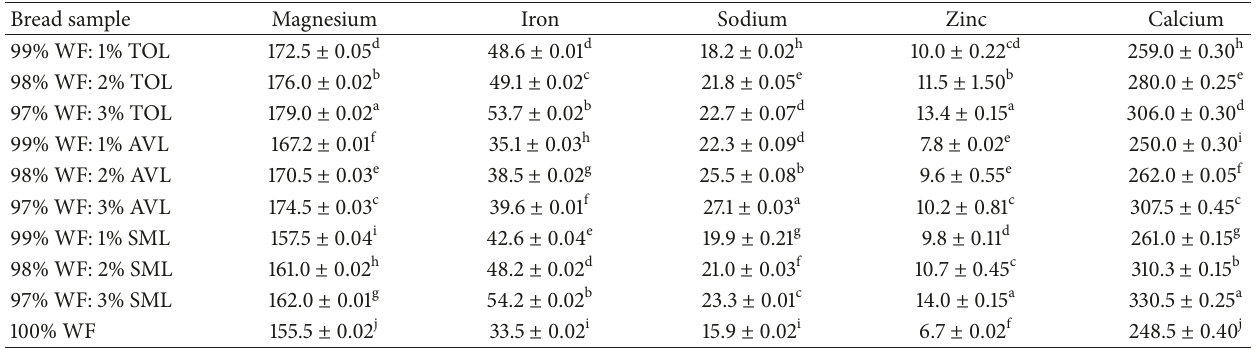
Table 3: Mineral nutrients (mg/100g) of wheat bread fortified with green leafy vegetable powders. Bread sample Magnesium Iron Sodium Zinc